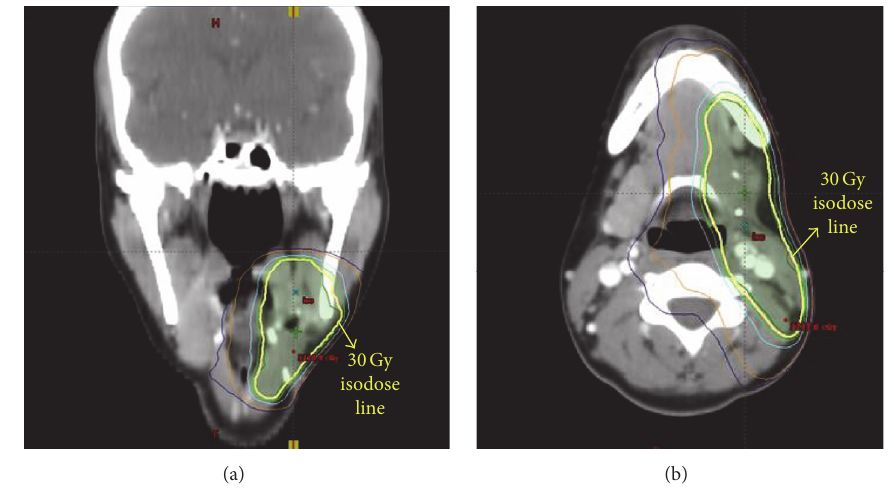
Figure 4: Coronal (a) and axial (b) images of radiation therapy treatment IMRT plan to 30 Gy.